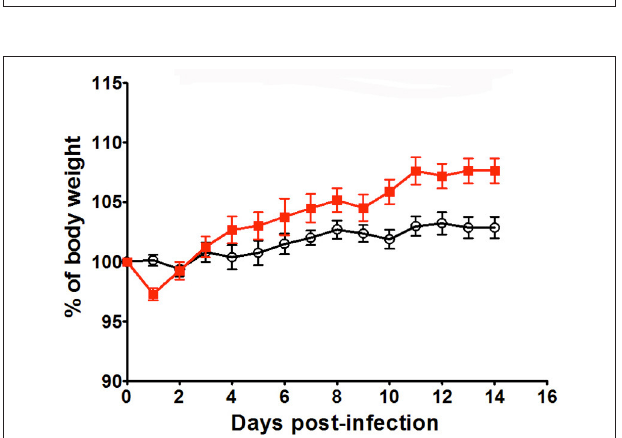
FIGURE 7 | Spleen of KO and WT mice in mock and infected conditions. Immunofluorescence of the spleen sections of WT (A,C) and KO (B,D) mice 48h after inoculation with DPBS (A,B) or S. pneumoniae (C,D) stained with anti-MARCO (green). Result shown is representative of 2 independent experiments.